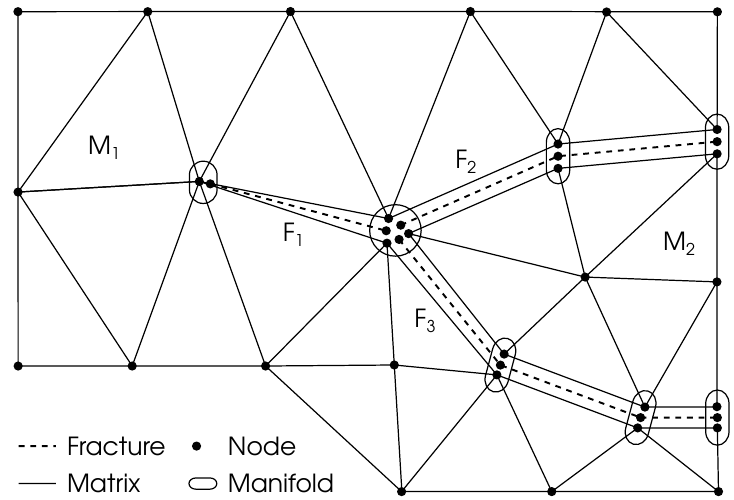
Figure 1. Triangular finite elements discretising two material patches M 1 and M 2 , and node–matched line elements representing three fractures F 1 , F 2 and F 3 . Manifolds are constructed at multiplicated nodes. This also applies to lower-dimensional fracture